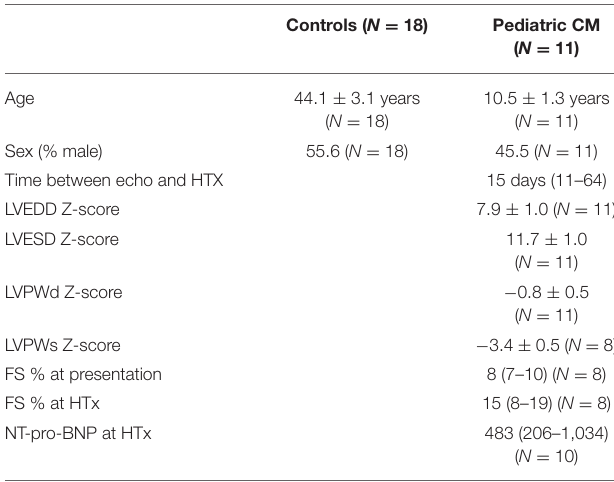
TABLE 1 | Patient